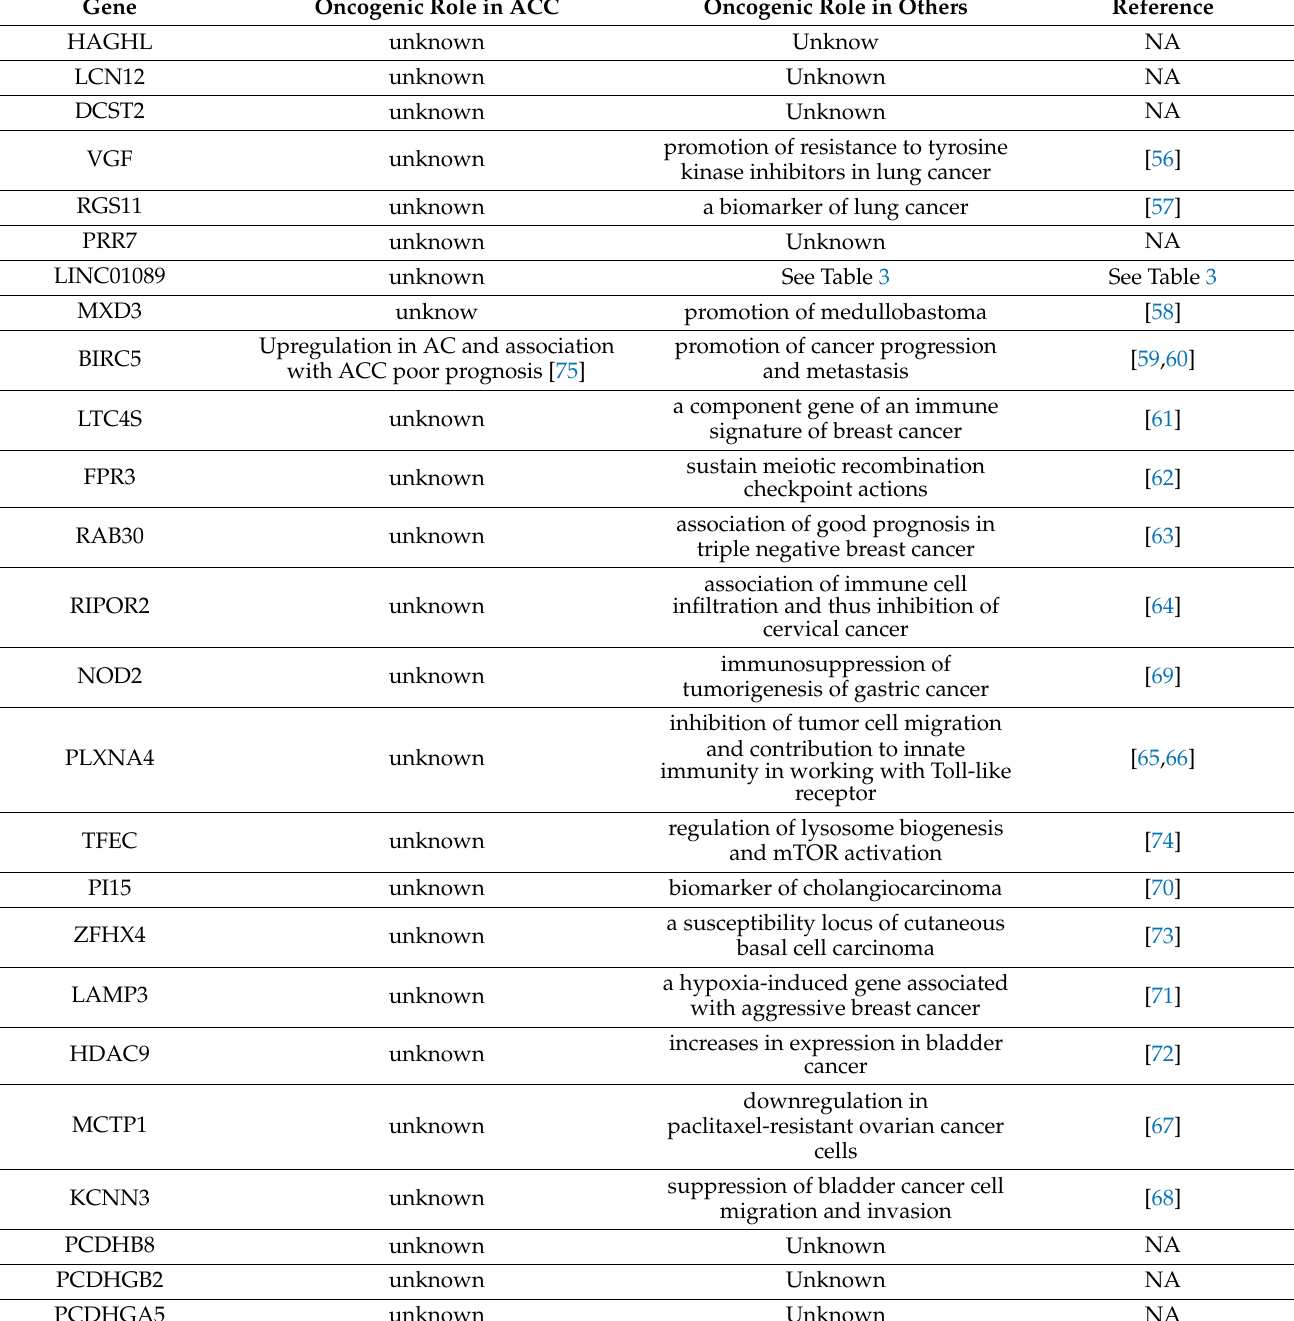
Table 4. Oncogenic role of the Sig27var25 component